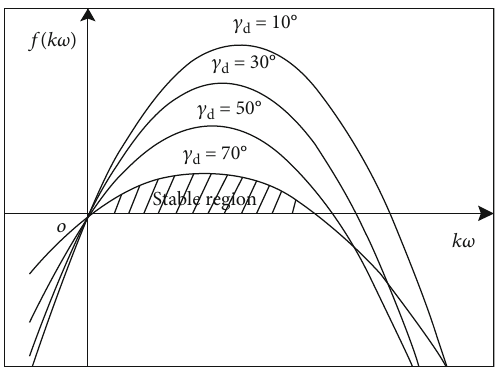
Figure 6: The stable region for di ff erent delay angles.